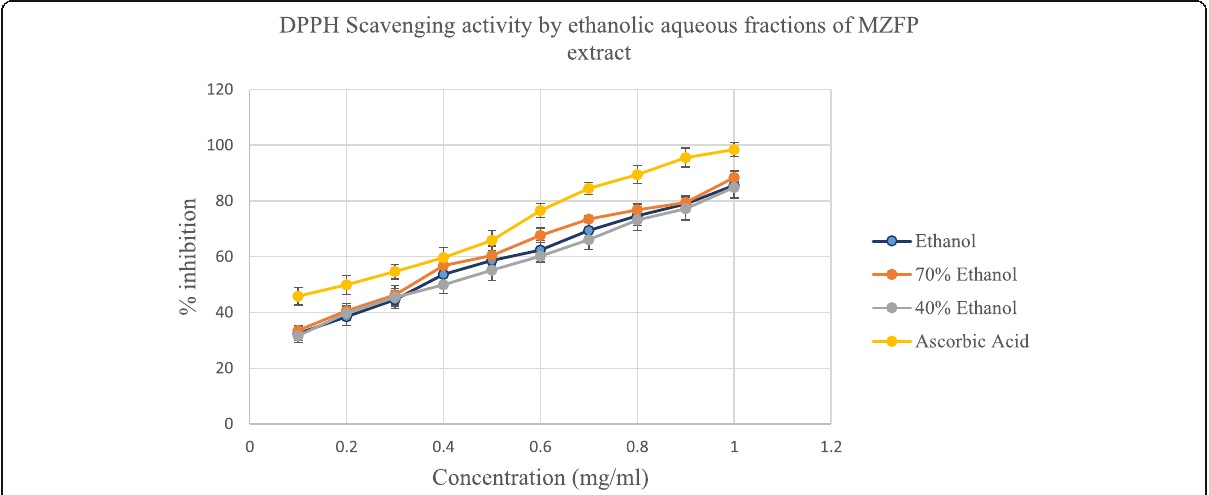
Fig. 2 DPPH scavenging activity by ethanolic aqueous fractions of MZFP extract. (Values are expressed as mean ± SEM of three determinations)